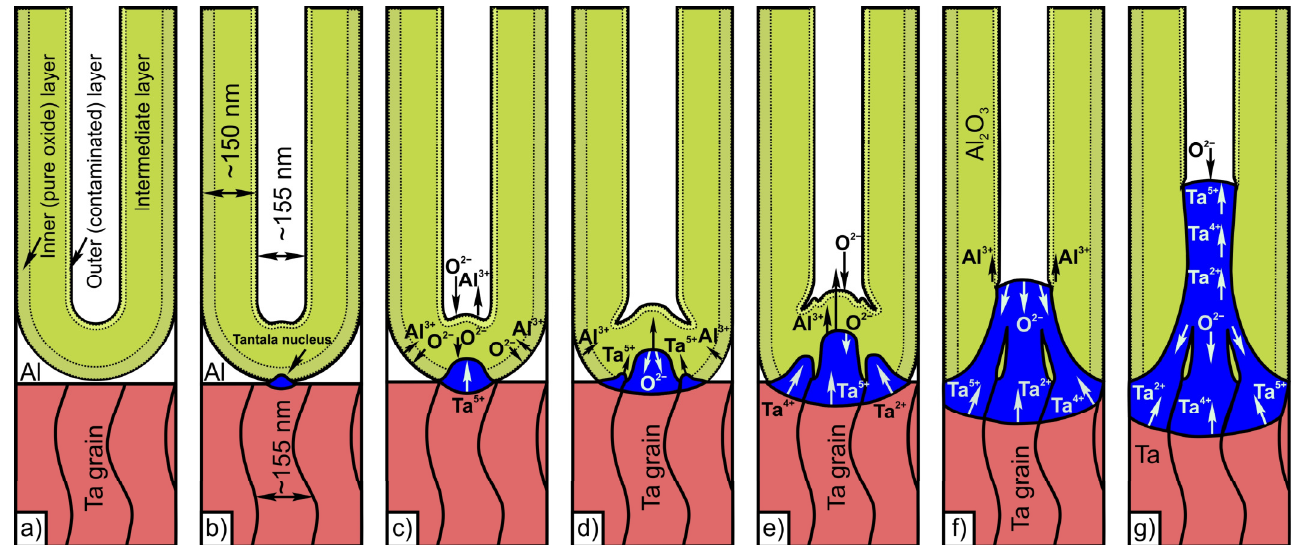
Figure 8. Ionic transport and anodic oxide growth during the PAA-assisted anodizing/reanodizing of the hexagonally packed tantalum: ( a ) porous anodizing of the Al layer, ( b ) nucleation of anodic oxide from tantalum grain, ( c ) complete anodic oxidation of the grain surface, ( d ) nucleation of anodic oxide on tantalum neighboring grains, ( e ) growth of tantala from grains, ( f ) merging of tantala grains at pore bases, ( g ) beginning of the hexagonally packed tantalum reanodizing, and steady-state growth of tantala during the reanodizing.